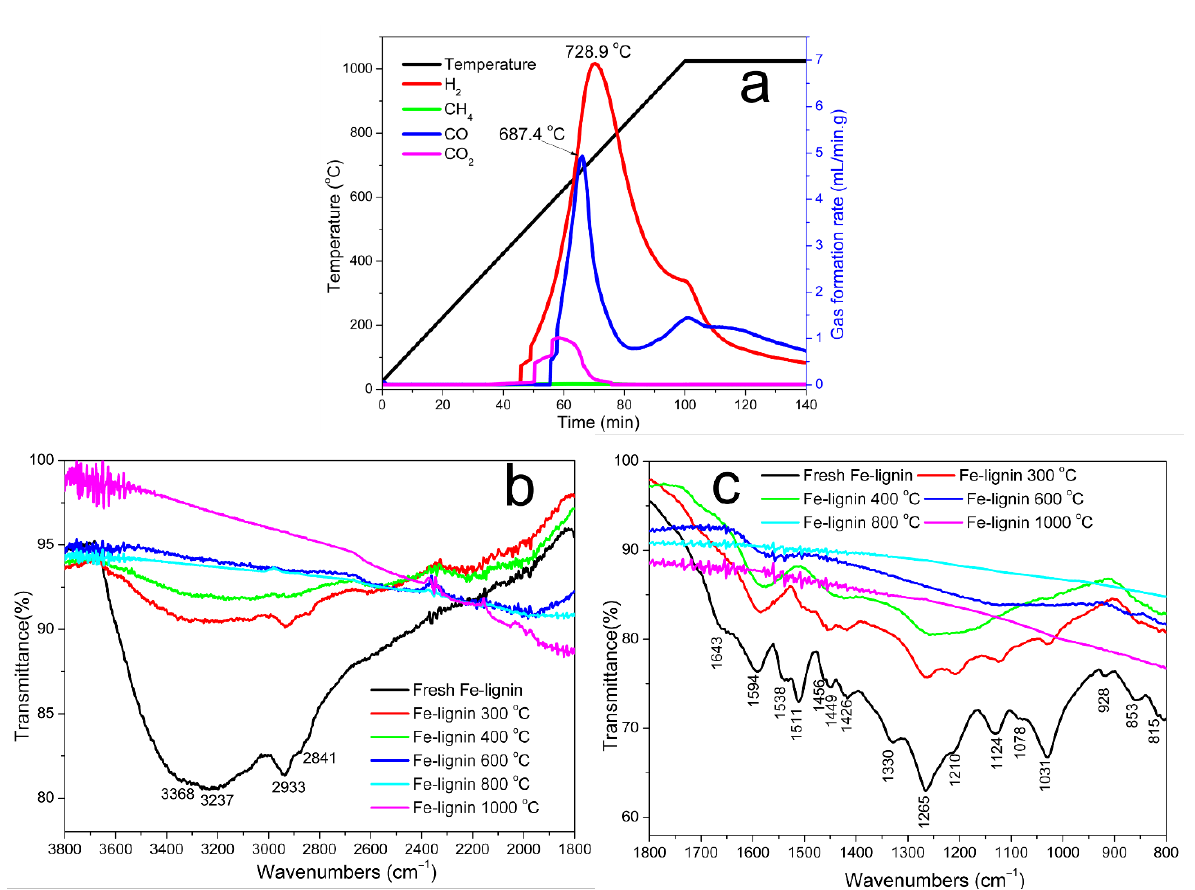
Figure 1. Gas evolution profiles ( a ) of temperature-programmed carbonization of the stabilized Fe-lignin composites under argon atmosphere and FTIR spectra ( b , c ) of the Fe-lignin composite thermally treated at different temperatures: 300 °C, 400 °C, 600 °C, 800 °C, and 1000 °C, respectively.